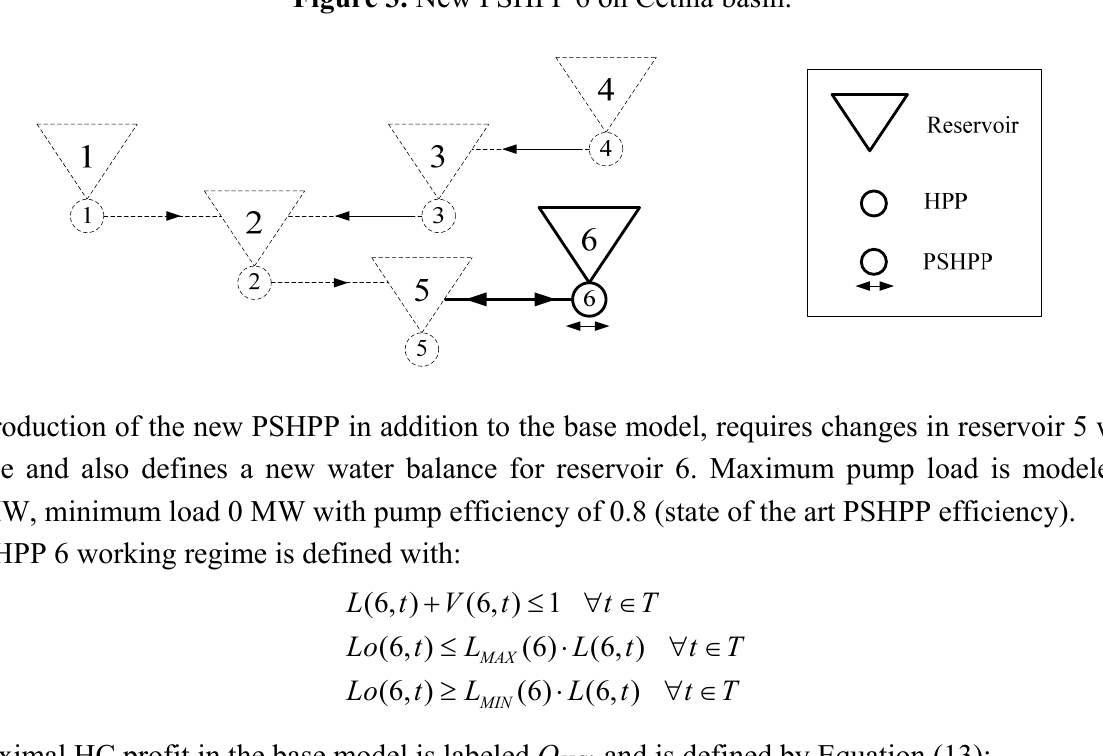
Figure 3. New PSHPP 6 on Cetina